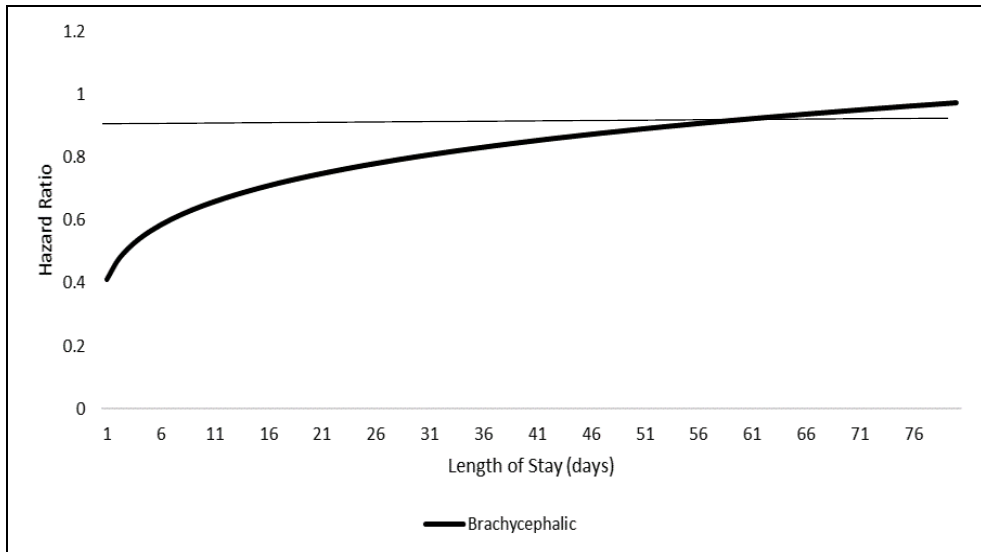
Figure 3. Model adjusted skull type by length of stay interaction displayed as hazard ratios, estimated from the simple random sample of 4500 dogs compared to the referent mesocephalic group.